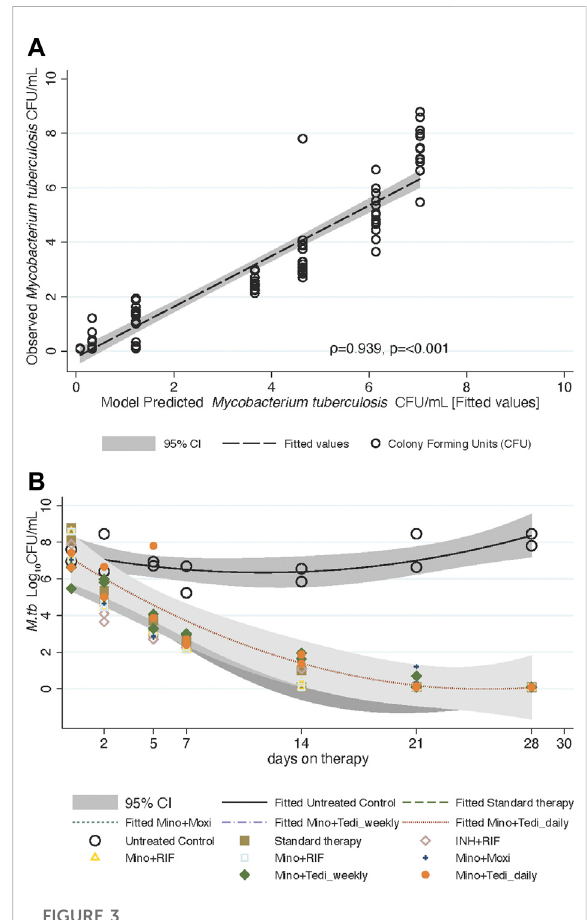
FIGURE 3 Mycobacterium tuberculosis trajectories and γ f in HFS-TB treated. (A) The modeled cfu/mL versus observed cfu/mL using ordinary differential equation # 1 for all data points are shown, as a diagnostic. The model was a very good fi t. (B) Shaded areas are 95% credible intervals. Many of the γ f overlapped, but the most steep (deepest gray) was the minocycline-rifampin combination regimen. In the non-treated HFS-TB, bacteria